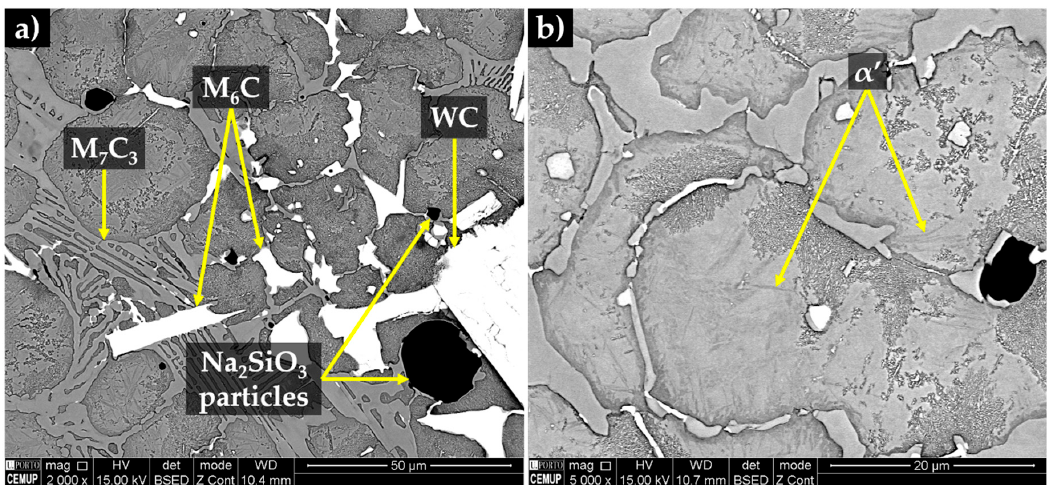
Figure 17. SEM-BSE images of the microstructure of the composite zone; ( a ) a network of eutectic constituent ((Fe,Cr) 7 C 3 and (Fe,W,Cr) 6 C + α ’), (Fe,W,Cr) 6 C next to the WC carbides and globules of Na 2 SiO 3 and ( b ) martensite ( α ’).